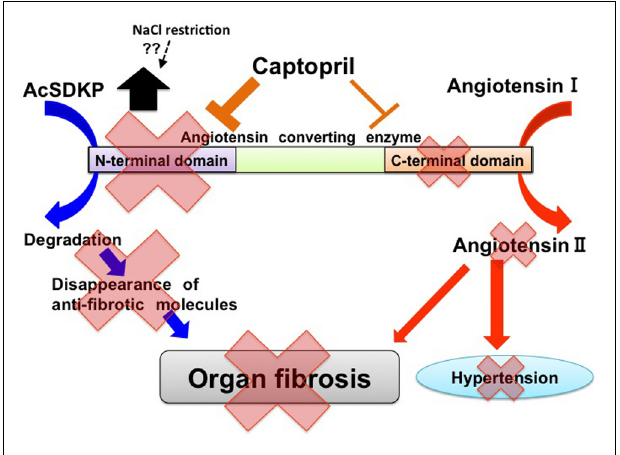
FIGURE 2 |Two catalytic domains ofACE and biological roles ofACE in tissue fibrosis. In ACE, there are two catalytic sites. Angiotensin I exerts higher affinity for the C-terminal catalytic site of ACE. AcSDKP is a substrate for the N-terminal domain. ACE may induce tissue fibrosis by both the production of angiotensin II and the decreased level of AcSDKP. Captopril exhibits higher affinity for the N-terminal catalytic sites of ACE when compared with C-terminal catalytic sites. Furthermore, NaCl restriction on top of RAS-blockade may increase AcSDKP levels by unknown